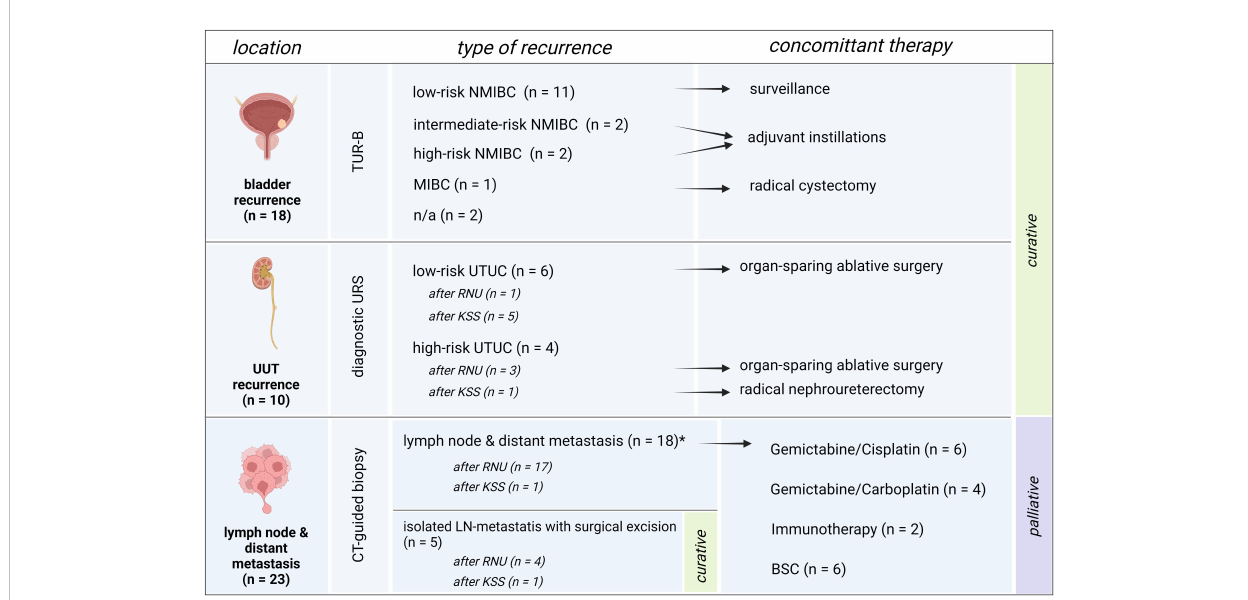
FIGURE 3 Overview of recurrences and subsequent therapies. Patient setting with bladder recurrence, recurrence of the upper urinary tract or distant metastasis, and their subsequent therapies. Bladder recurrence was treated in line with the treatment algorithm for primary bladder cancer. Low-risk UTUC recurrence of the upper urinary tract was treated with organ-sparing ablative surgery whenever possible. High-risk recurrence of the remaining UUT after RNU was treated with KSS whenever possible, and in KSS, radical surgery by means of RNU was applied whenever high-risk recurrence of the UUT occurred. Patients with solely lymph node recurrence were excised surgically with no further need of systemic therapy and therefore remained in a curative setting. Patients with metastatic disease were assigned to systemic therapy or best-supportive care depending on the patient status and therapy